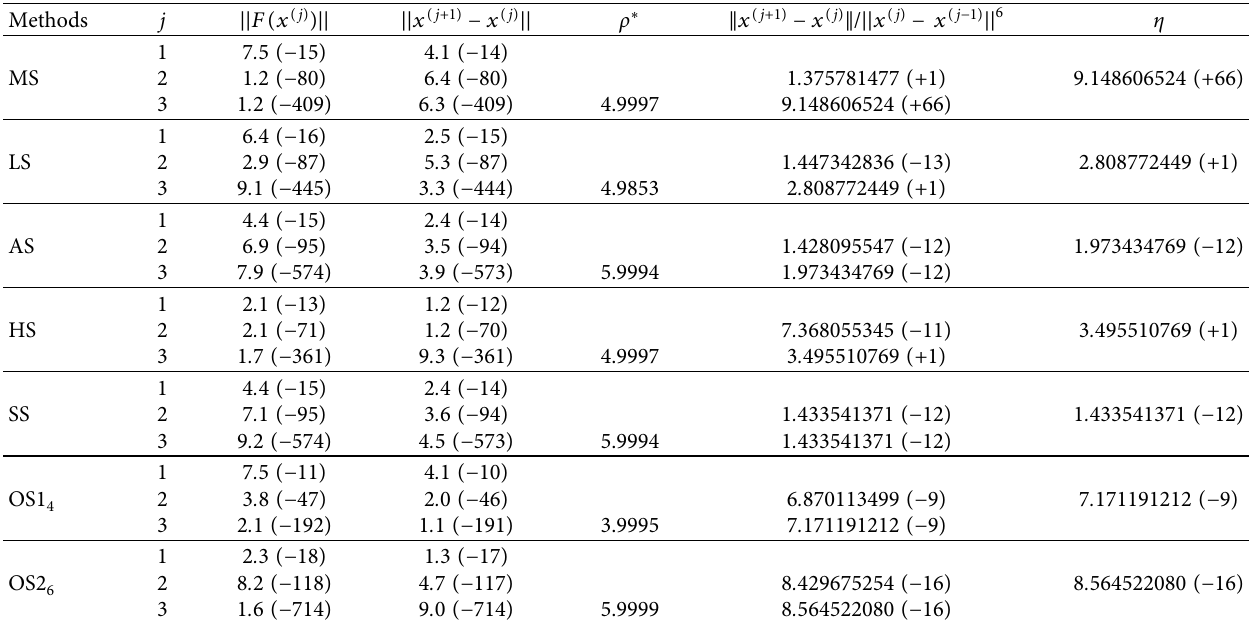
Table 3: Convergence behavior of different methods on 2D Bratu problem (34).